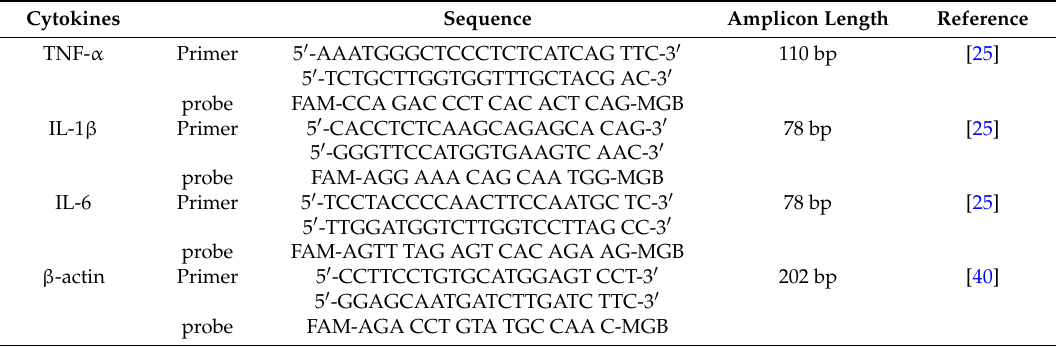
Table 2. Primers and probes of proinflammatory cytokines (TNF- α , IL-1 β , and IL-6) for real-time PCR.